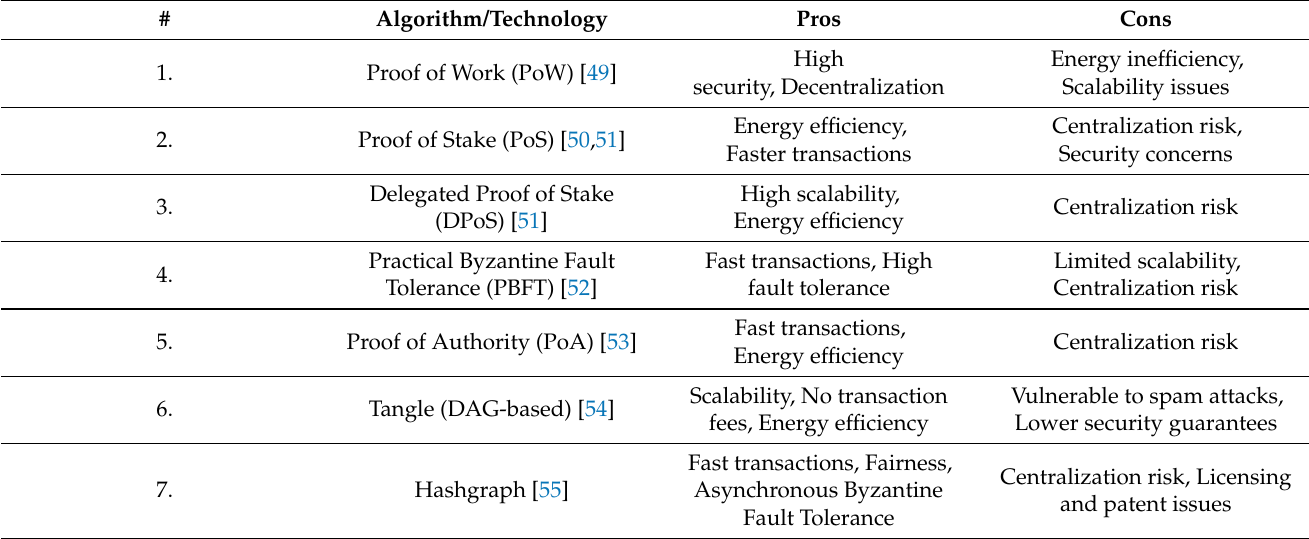
Table 2. Comparison of Consensus Algorithms and